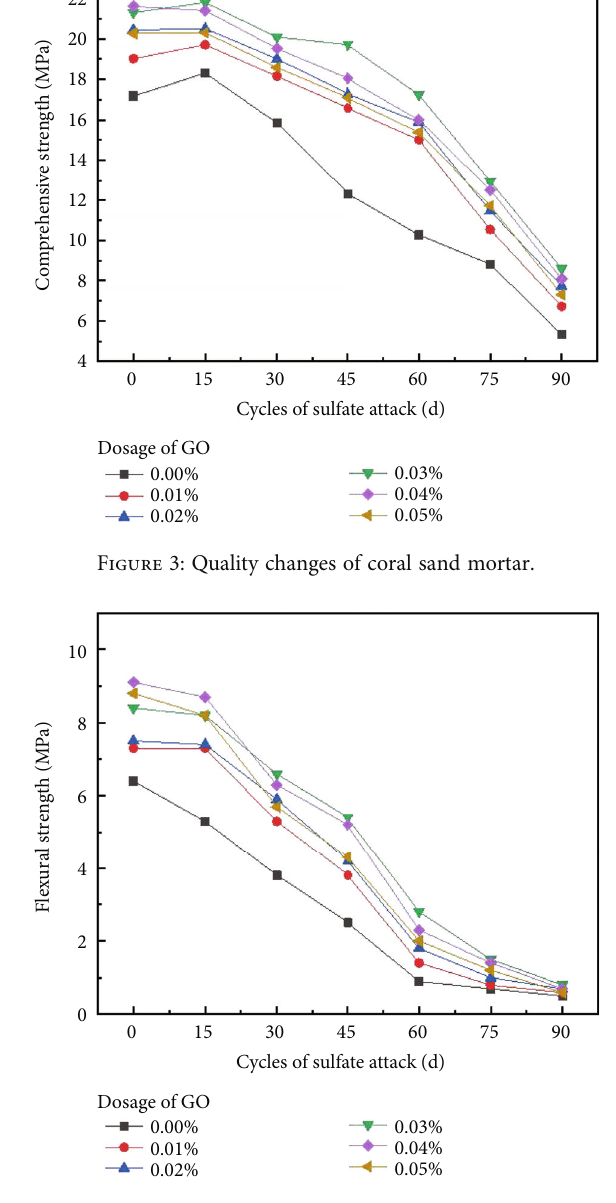
Figure 4: Quality changes of coral sand mortar.